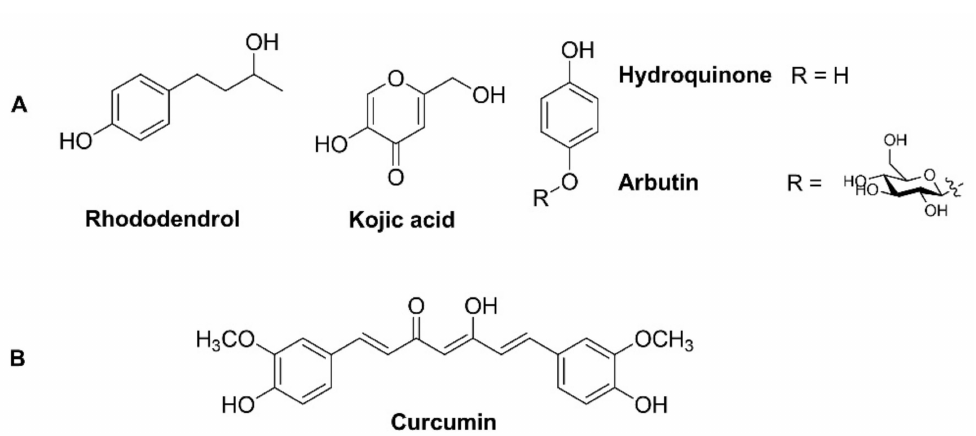
Figure 2. ( A ) Natural tyrosinase inhibitors ( B ) Curcumin